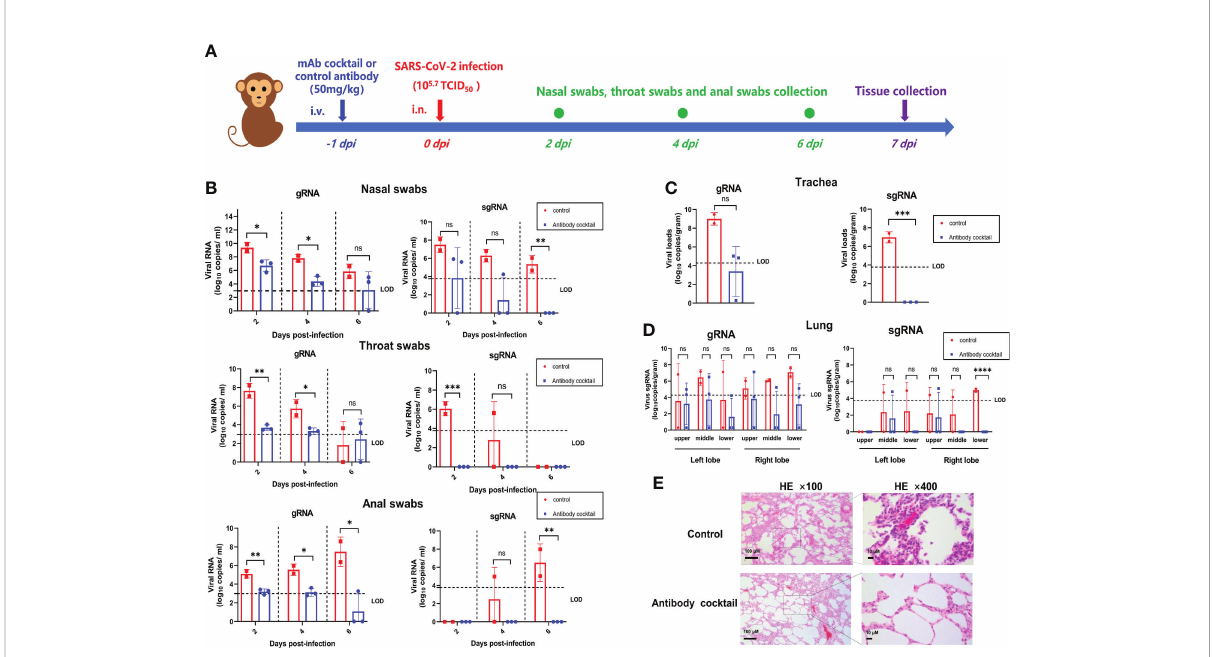
FIGURE 4 The 11-2G/18-4A cocktail showed potent prophylactic ef fi cacy in SARS-CoV-2-infected cynomolgus macaques. (A) Schematic diagram of antibody treatment and SARS-CoV-2 challenge in cynomolgus macaques. (B) Nasal, throat and anal swabs were collected at 2, 4, 6 days post- infection. (C) Trachea and (D) Lungs (both left lobe and right lobe) were obtained at 7 days post-infection. Viral load was assessed by detection of SARS-CoV-2 genomic RNA and subgenomic RNA using qRT-PCR. Data are shown as mean ± SD. An unpaired Student ’ s t-test (two-tailed) was used for statistical analysis, and the relevant p-values are indicated (not indicated in graph; *p < 0.05, **p < 0.01, ***p < 0.001, ****p < 0.0001). (E) H&E staining of lung tissues. ns, not signi fi